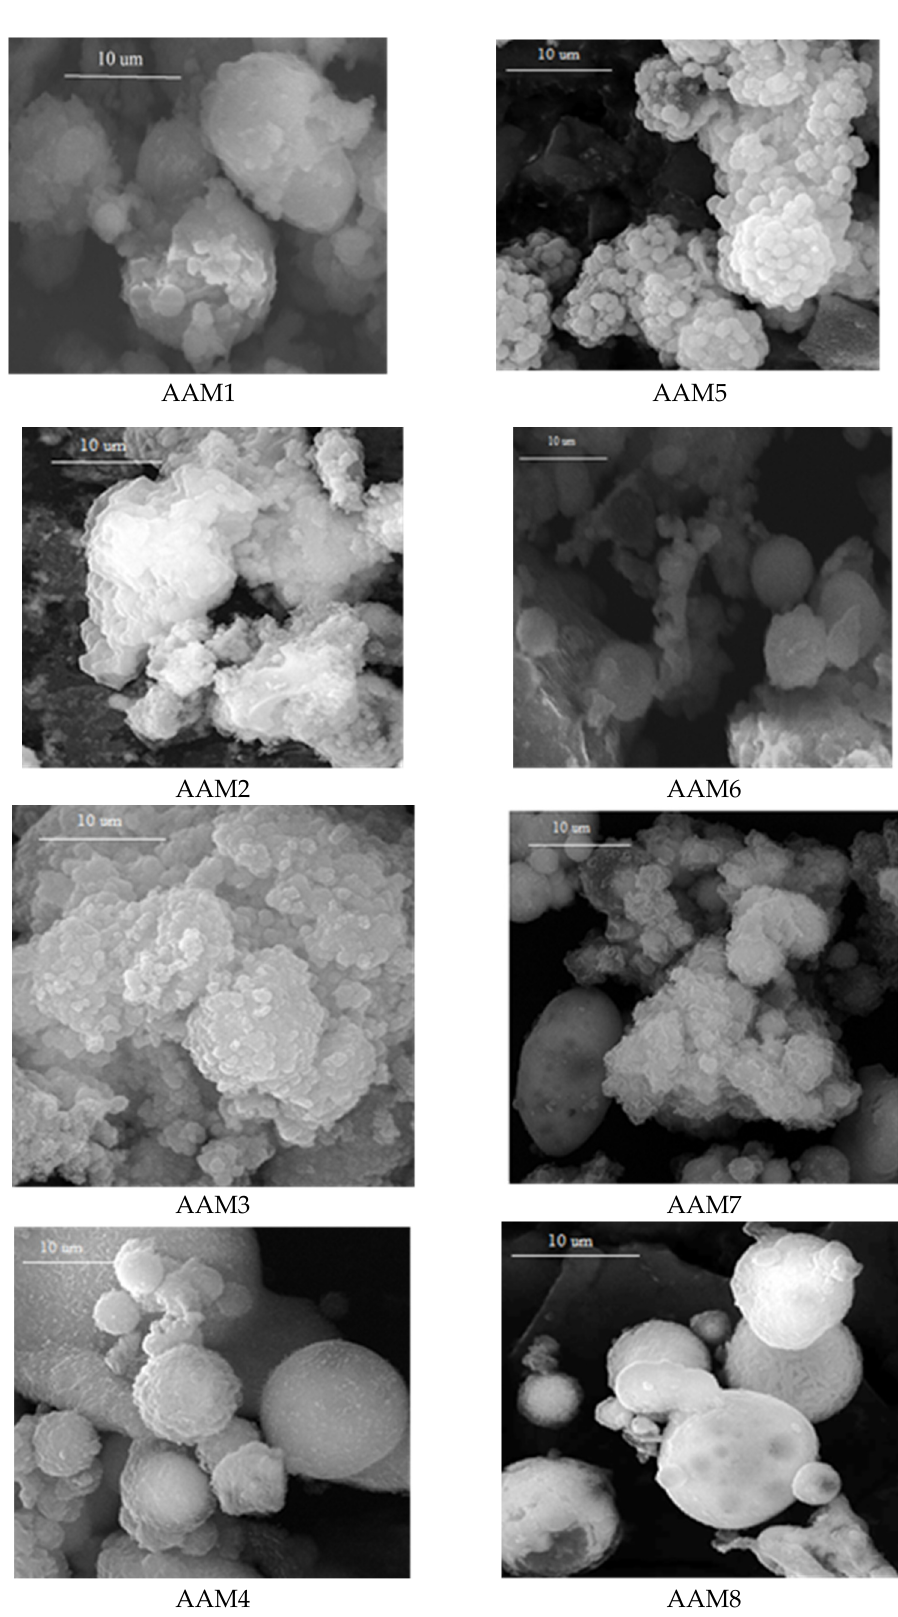
Figure 2. SEM micrograph of the fly ash samples processed by alkali treatments.